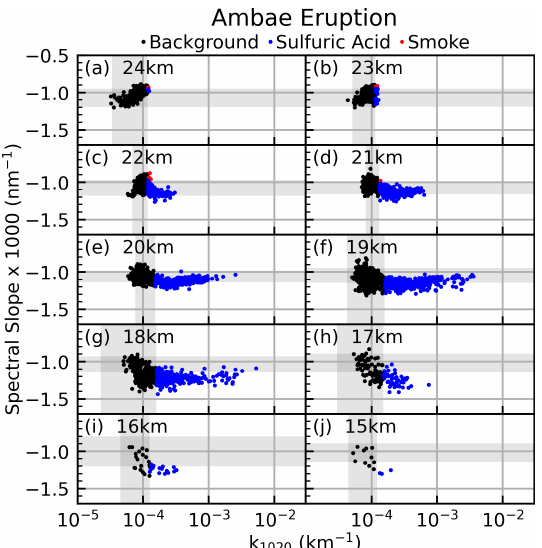
Figure 5. Same as Fig. 4, but for the Ulawun